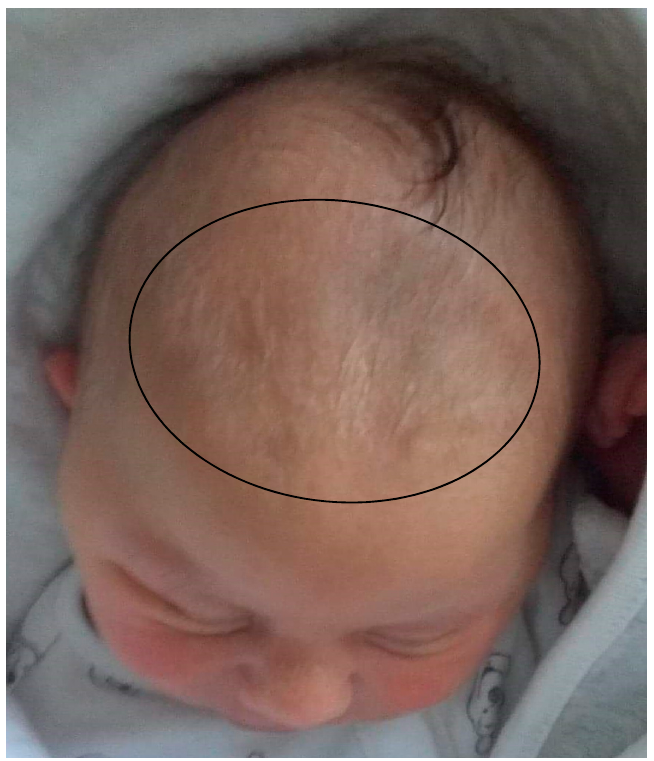
Figure 6. Neonate (Patient 1) with KBG syndrome and a very wide anterior fontanel.